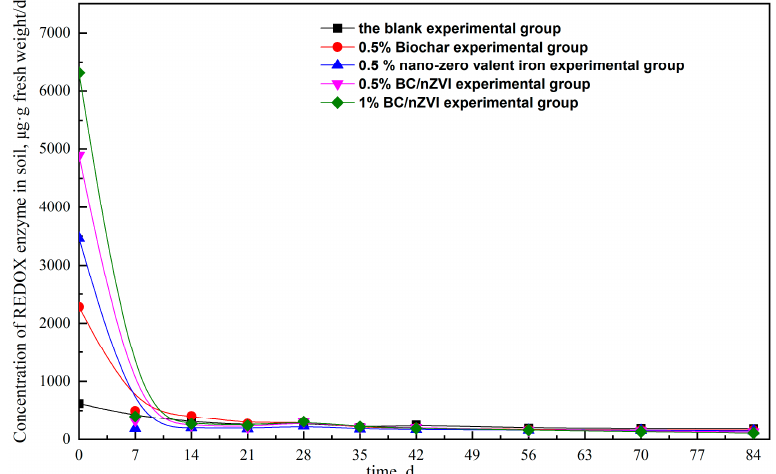
Figure 7. Effect of material addition on soil dehydrogenase activity.